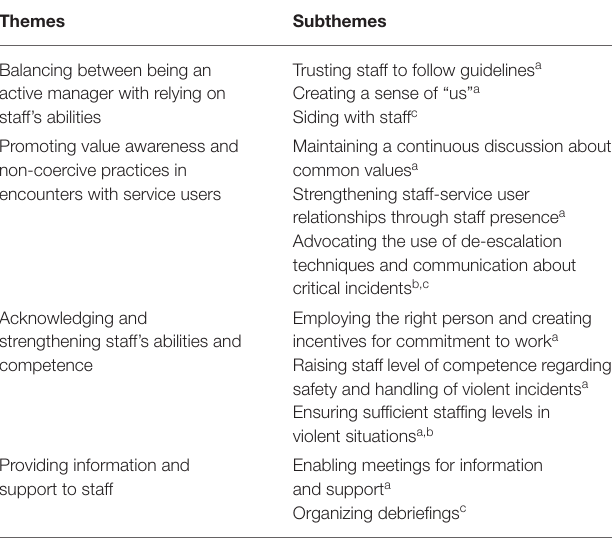
TABLE 1 | Themes and subthemes identified on different levels of prevention.